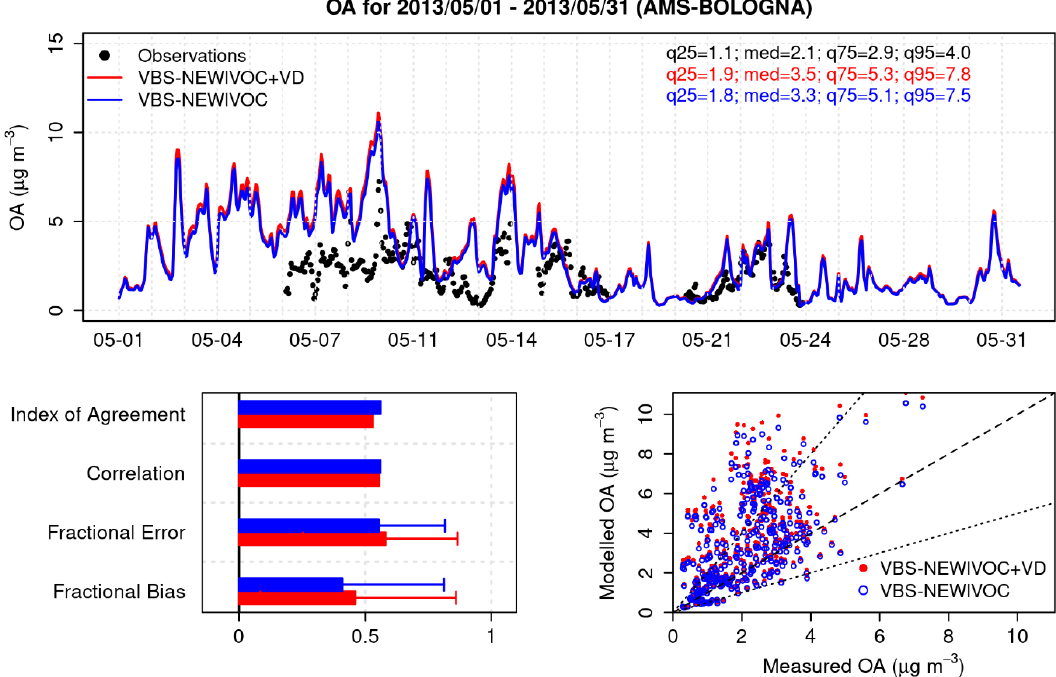
Figure 13. Comparison among modeled and observed (black) OA concentrations in May 2013 at the Bologna site: VBS scheme with new parameterizations for IVOC emissions (VBS-NEWIVOC, blue) and VBS scheme with new parameterizations for IVOC emissions and revised volatility distribution (VBS-NEWIVOC+VD,